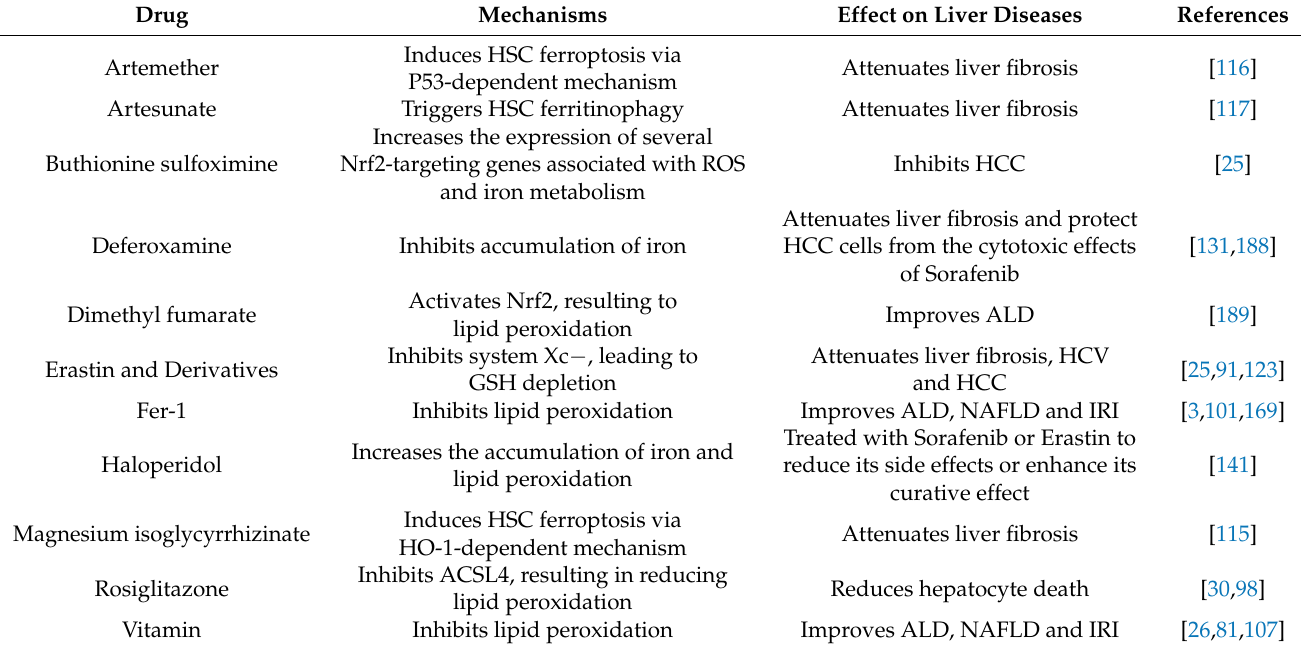
Table 3. Drugs Targeting Ferroptosis in Liver